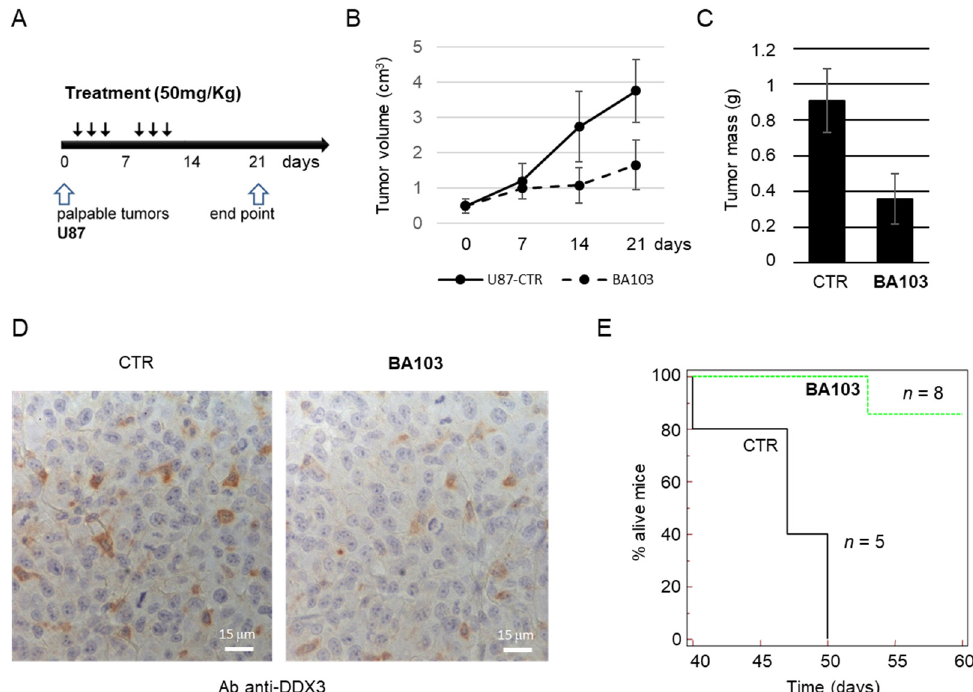
Figure 9. Biological activity of BA103 in xenograft models of GBM. ( A–D ) Mice were inoculated s.c. with U87 cells, randomly distributed in two groups (CTR and BA103 ), and treated according to the protocol shown in panel ( A ). Tumor growth was monitored by measuring tumor volume ( B ), and at the end point, tumors were weighed, and the resulting mean values for each group are reported in the histogram ( C ). Recovered tumor masses were processed for analysis of DDX3X expression by immunohistochemistry, and representative images acquired at 400× magnification are shown in panel ( D ). ( E ) Survival curve from in vivo orthotopic model of GBM. Mice were divided in two groups, control (CTR, n = 5) receiving vehicle, and inhibitor-treated ( n = 8) receiving an i.p. injection of 50 mg/kg BA103 . Mice were monitored for two months after U87 cells inoculation.